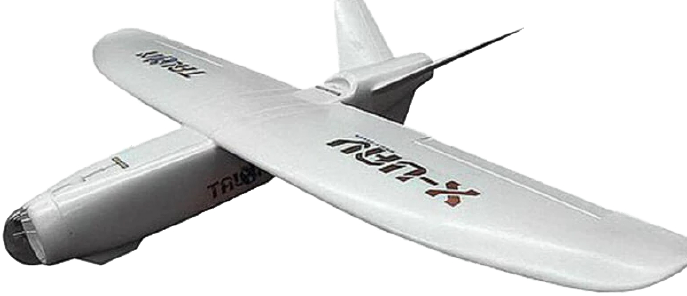
Figure 13. X-UAV Talon. Plane used for test in